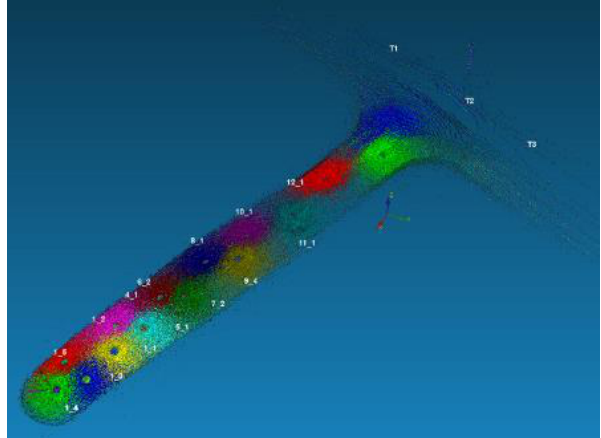
Figure 5. Acquired data of the reference epoch of groyne 31 representing the 15 scan stations by different